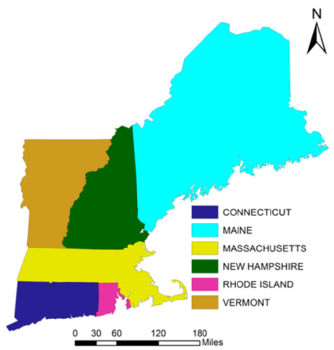
Figure 1. The New